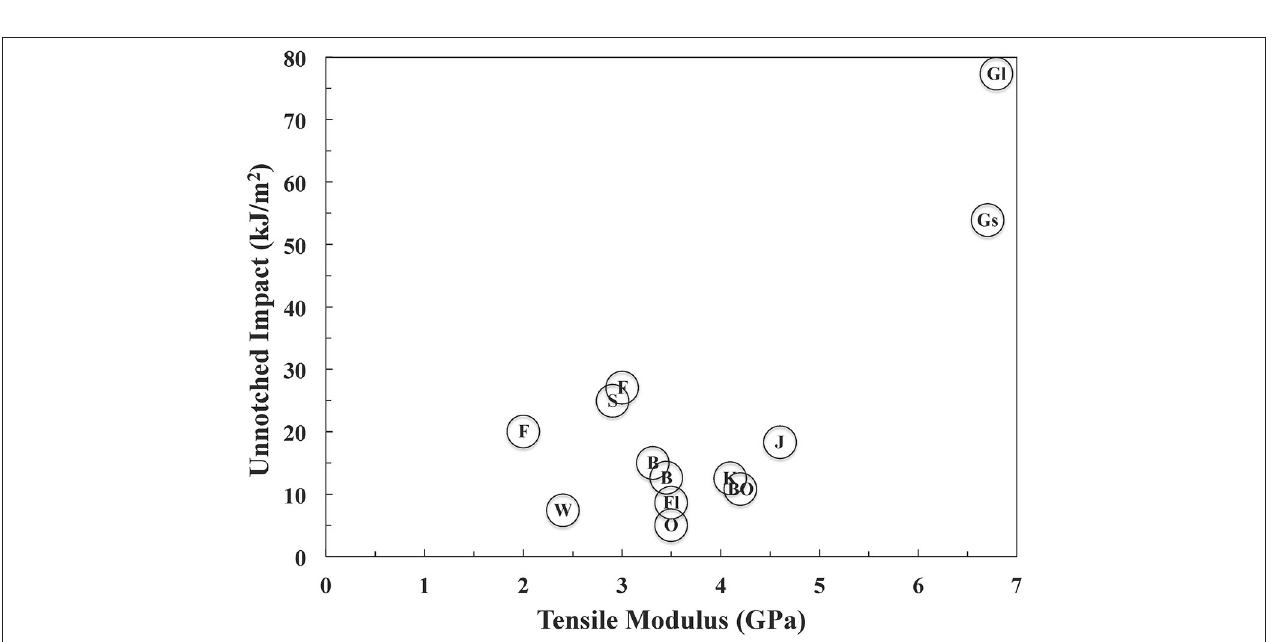
FIGURE 4 | Unnotched Impact Vs. Tensile Modulus for 30 wt% fiber reinforced polypropylene covered by the papers in this review.